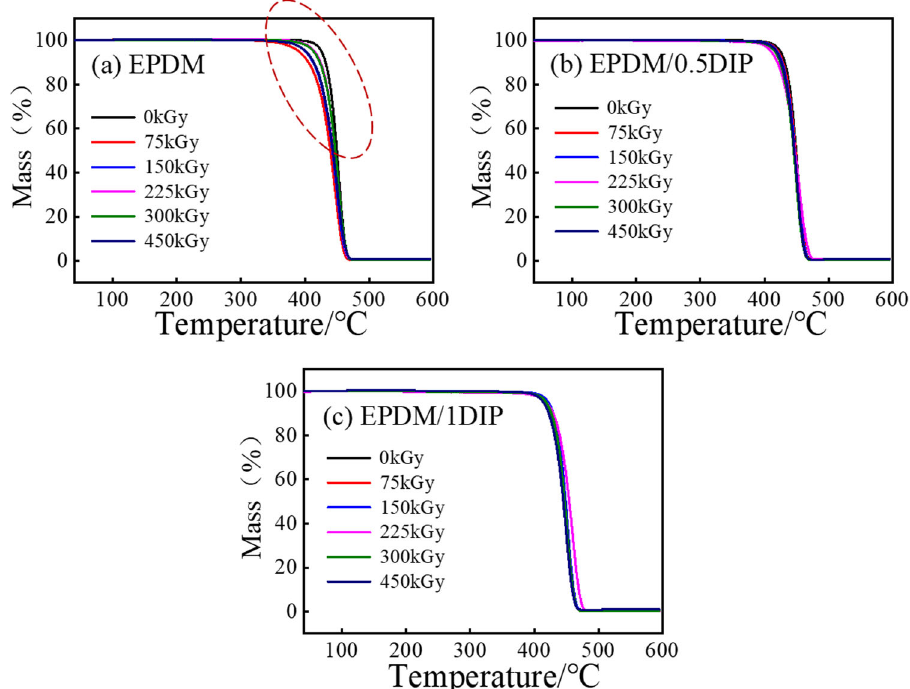
Fig. 1 TGA curves of the EPDM and EPDM/DIP blends at different γ -irradiation doses. a EPDM, b EPDM/0.5DIP blend, c EPDM/1DIP blend.